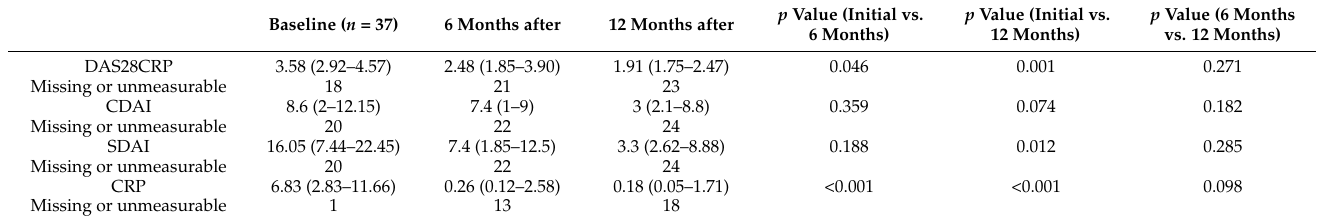
Table 6. Changes in disease activities of RA during the course after PCP